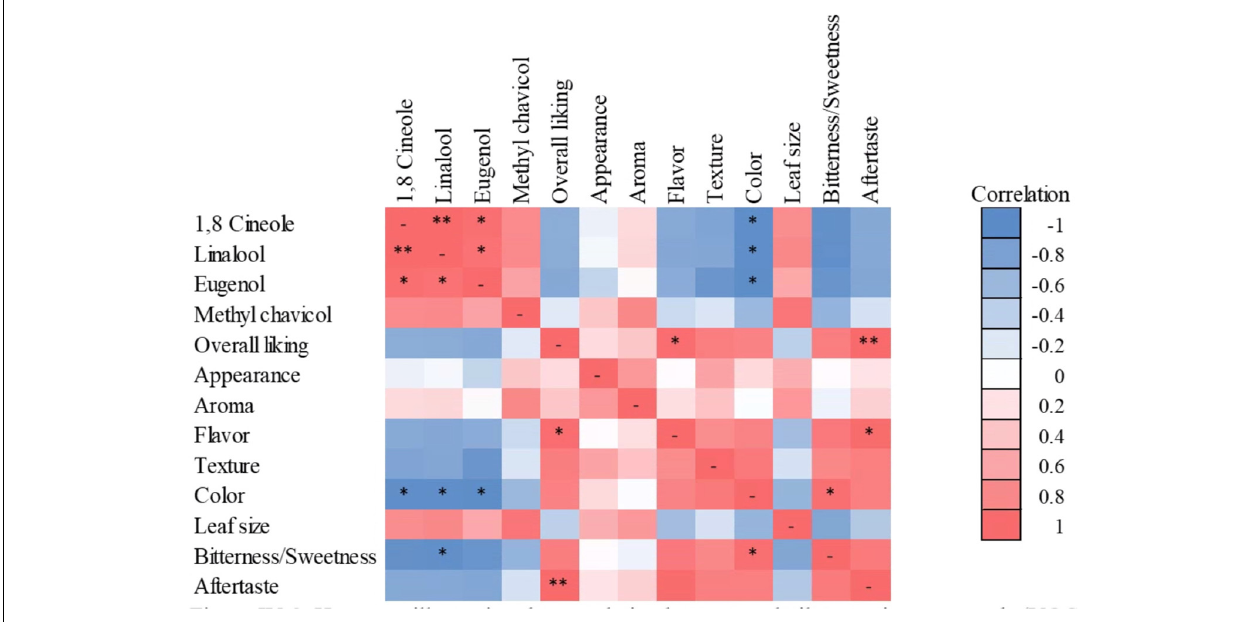
FIGURE 9 | Heat map illustrating the correlation between volatile organic compounds (VOCs) and sensory preference characteristics of sweet basil “Nufar” ( Ocimum basilicum ) grown under radiation intensities of 100, 200, 400, or 600 µ mol · m − 2 · s − 1 photosynthetic photon flux density (PPFD). Blue and red represent negative and positive correlations, respectively. Asterisks indicate significant correlations based on Pearson correlation * P < 0.05; ** P <